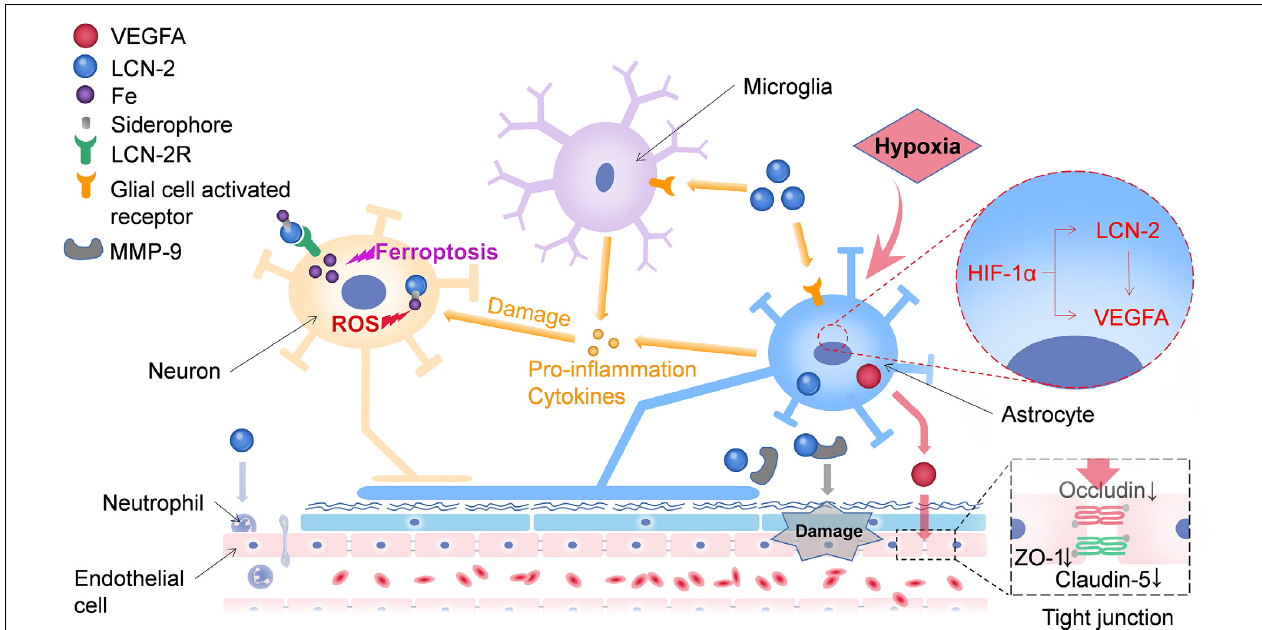
FIGURE 1 | LCN-2 can damage neurons through multiple pathways. On one hand, Lipocalin-2 can transport iron into neurons by binding to LCN-2R, leading to the accumulation of intracellular iron, which in turn triggers ferroptosis and oxidative stress in neurons. On the other hand, LCN-2 can activate glial cells to release pro-inflammatory factors, which in turn damage neurons. LCN-2 has several ways to damage the BBB. First, it can promote the release of VEGFA from astrocytes, disrupt tight junctions between endothelial cells, and ultimately lead to leakage of the blood-brain barrier (BBB). Second, LCN-2 can bind to matrix metallopeptidase 9 (MMP-9), resulting in persistent BBB damage. Moreover, LCN-2 could induce neutrophil adhesion and damage the BBB. VEGFA, vascular endothelial growth factor A; LCN-2, lipocalin-2; LCN-2R, lipocalin-2 receptor; NVU, neurovascular unit; BBB, blood-brain